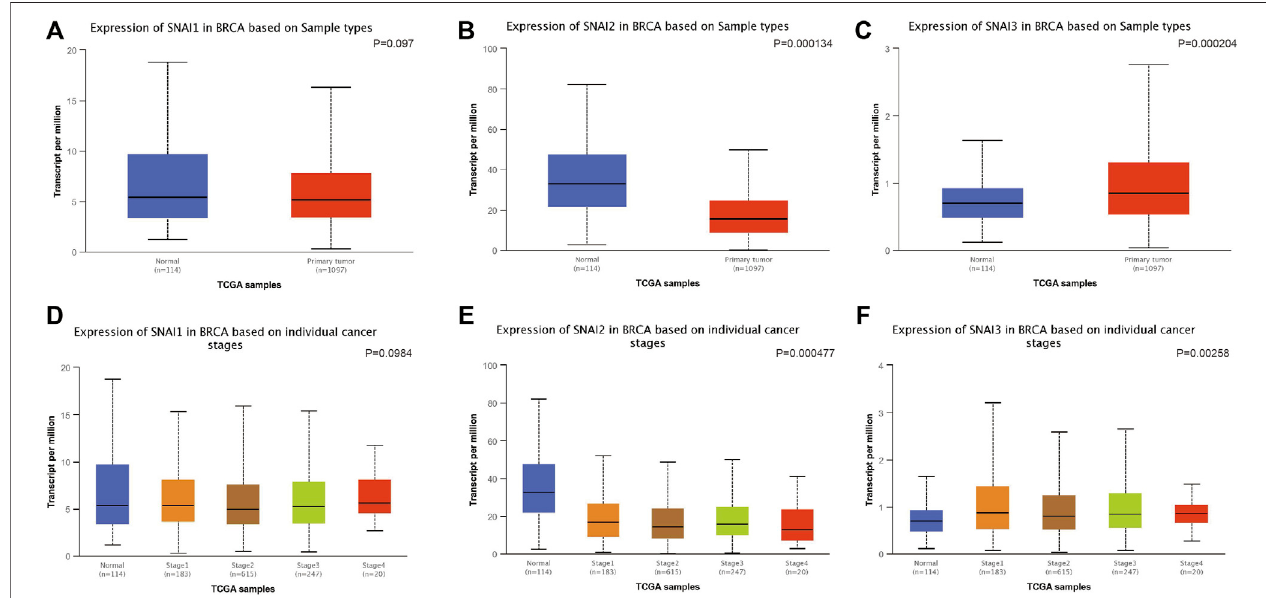
FIGURE2| CorrelationsbetweenSNAIexpressionandbreastcancer.Transcriptlevelsof SNAI1 (A) , SNAI2 (B) ,and SNAI3 (C) inbreastcancertissuescompared with normal tissues. Transcript levels of SNAI1 (D) , SNAI2 (E) , and SNAI3 (F) in various stages of breast cancer.